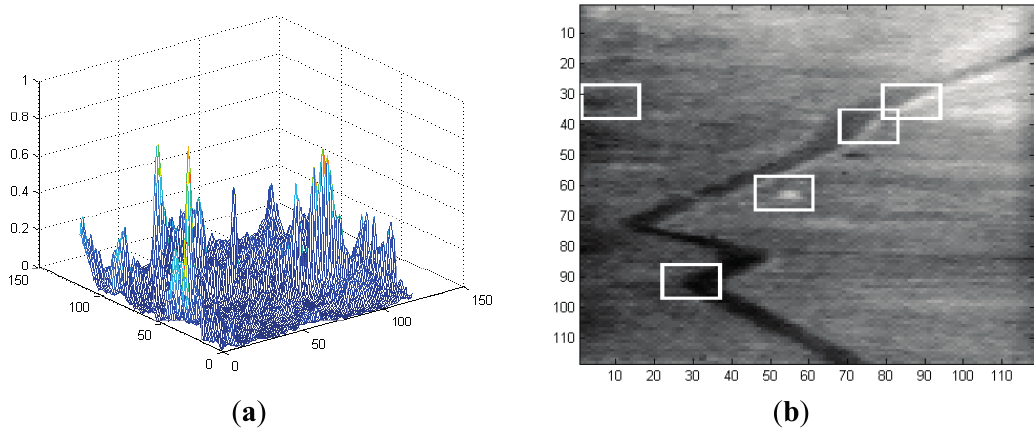
Figure 8. ( a ) Correlation output for Frame 1 of Sequence L2018 using MACH Range-1 filter along with notch filter; and ( b ) 5 ROIs in Frame